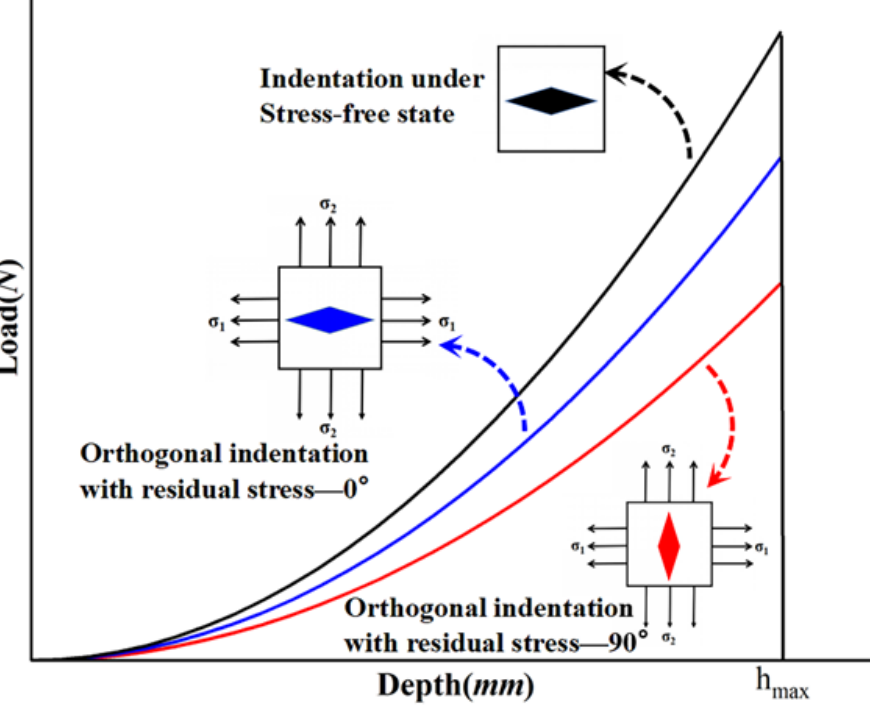
Figure 1. Load-Displacement Curve Obtained by Indentation equipment.